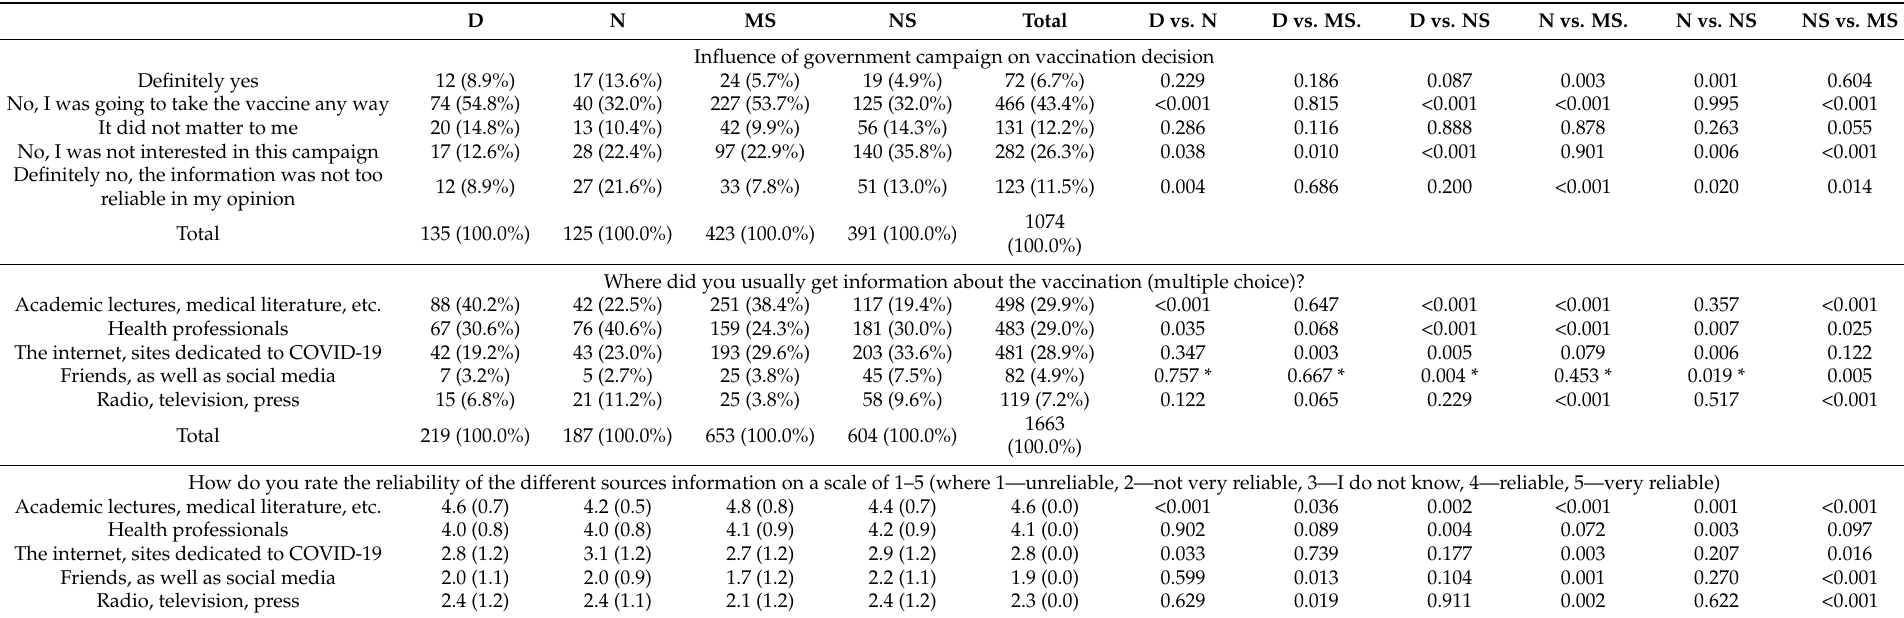
Table 3. Influence of the campaign and sources of obtained